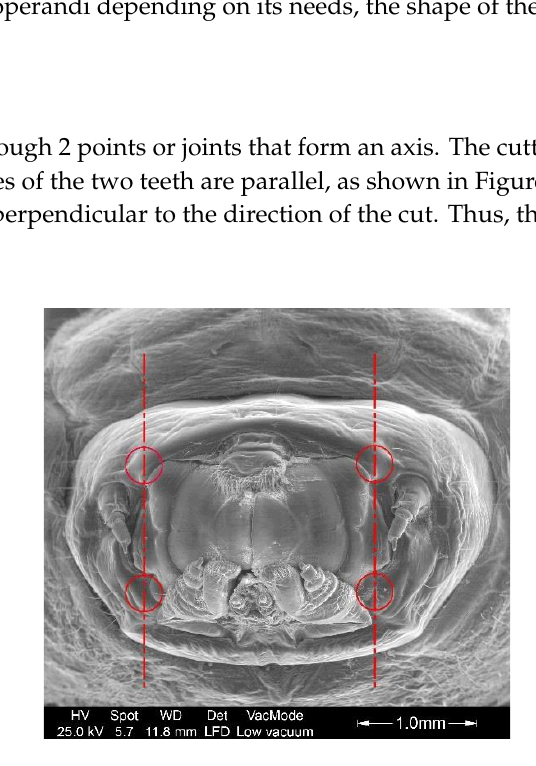
( b ) Figure 11. Distances and angles: ( a ) Jaw wedge angle β = 77.3 ° and the angle between segment A and the rake face c = 9.6°; ( b ) A = 1249 µm is the distance between cutting edge and insertion of the adductor, B = 1496 µm is the distance between the cutting edge and the articulation axis radius of rotation of the jaw, C = 2539 µm is the joint distance, a = 44.8° is the angle between segments A and B and b = 30.9° is the declination angle between segments B and C. The bite length (F = 800 μm) was obtained by measuring the length of the cutting footprint in the wood (Figure 9a). 3.6.2. Radius and Arches The radii that describe the flank face, cutting edge and radius of the edge were identified and measured, as shown in Figure 12.